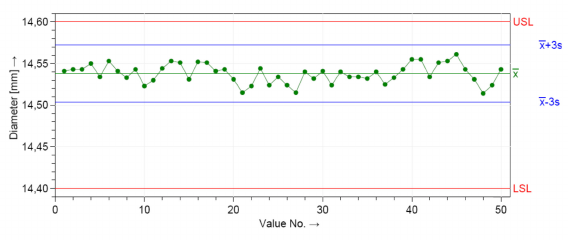
Figure 7. Control chart for the short-term capability study of the diameter dimension (D).